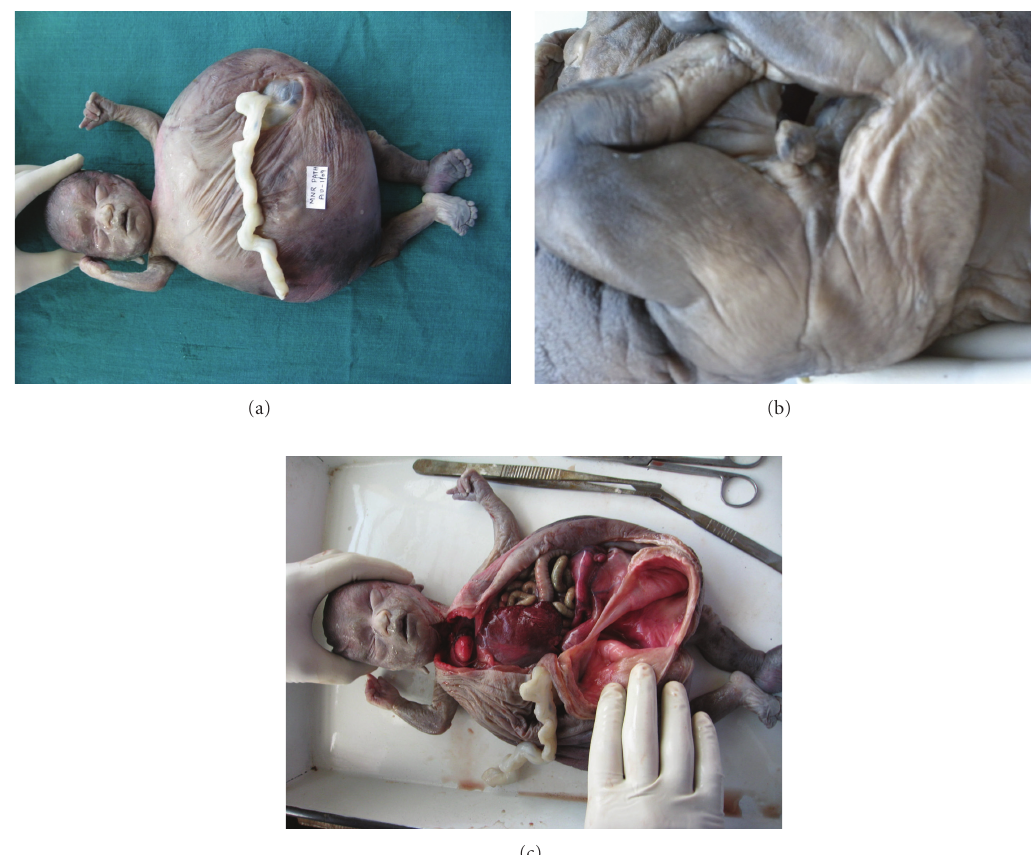
Figure 1: Gross findings. (a) Characteristic Potter’s facies, cystic dilatation of abdomen with wrinkles and defective insertion of umbilical cord. (b) Absence of anal opening, rudimentary scrotal sac and imperforate penis. (c) Cut opened cystically dilated